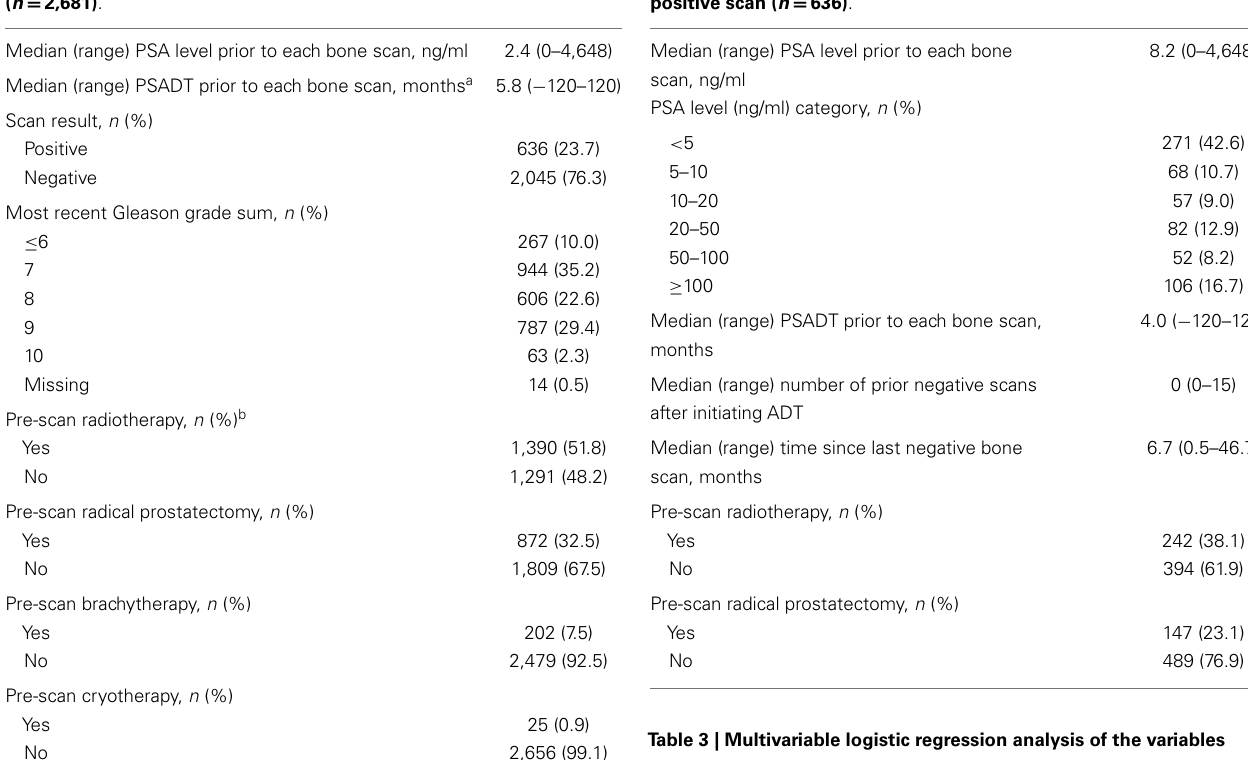
Table 2 | Patient and disease characteristics at the time of the first positive scan ( n = 636) .